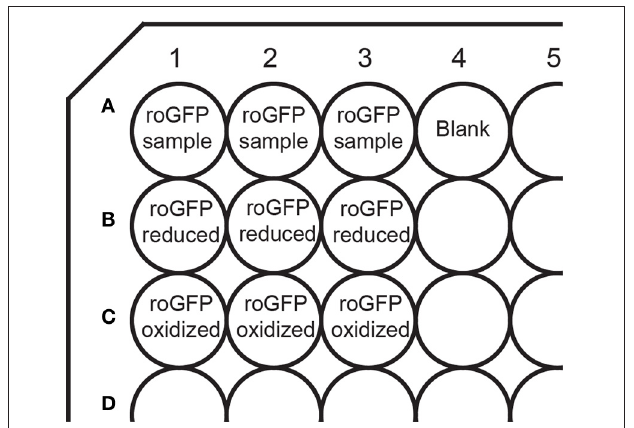
FIGURE 1 | Layout of a 96-well plate for measurements on a plate reader. The plate contains wells for fully oxidized and fully reduced controls, as well as a blank well containing buffer only for blank subtraction.